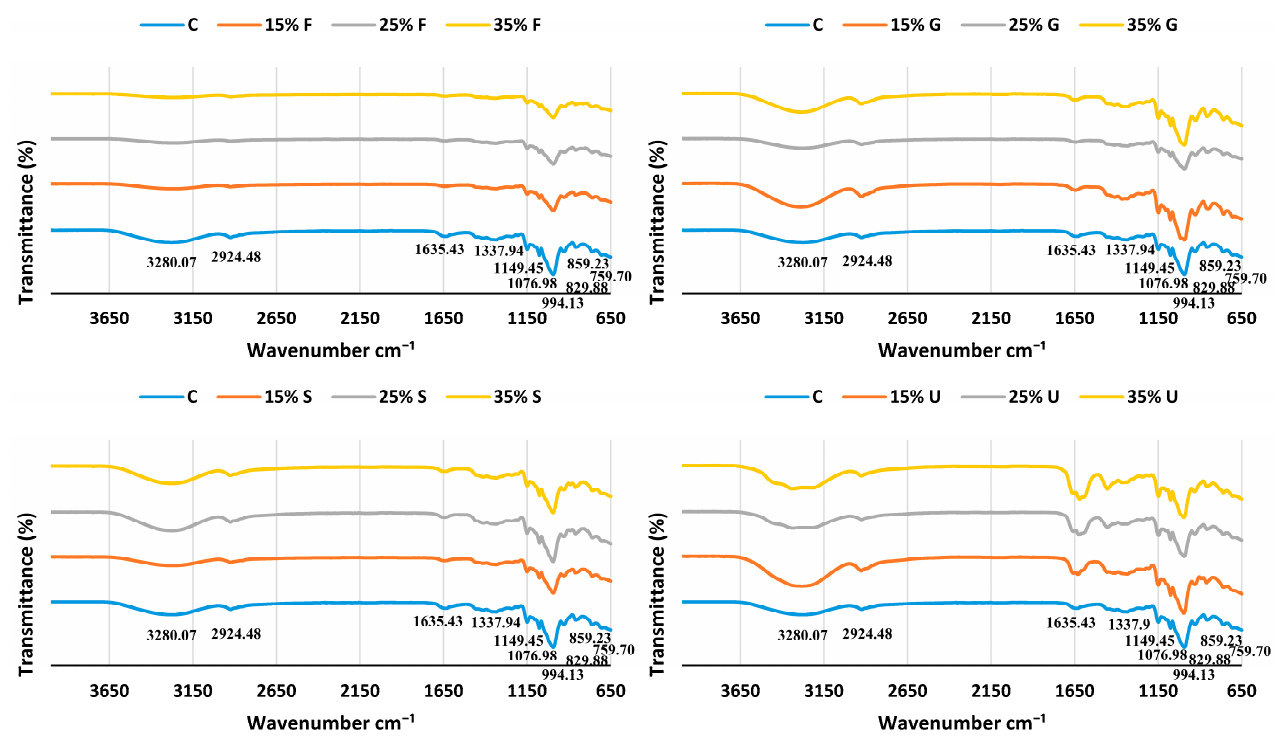
Figure 5. FTIR curves of wheat starch films with various plasticizer types at different concentrations.